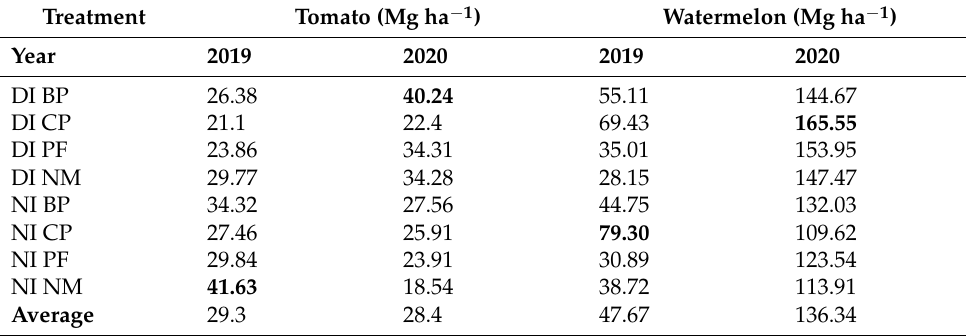
Table 6. Tomato and watermelon yield obtained from drip irrigation (DI) and no irrigation (NI) under clear plastic mulch (CP), black plastic mulch (BP), landscape fabric mulch (PF), and no mulch (NM) treatment in 2019 and